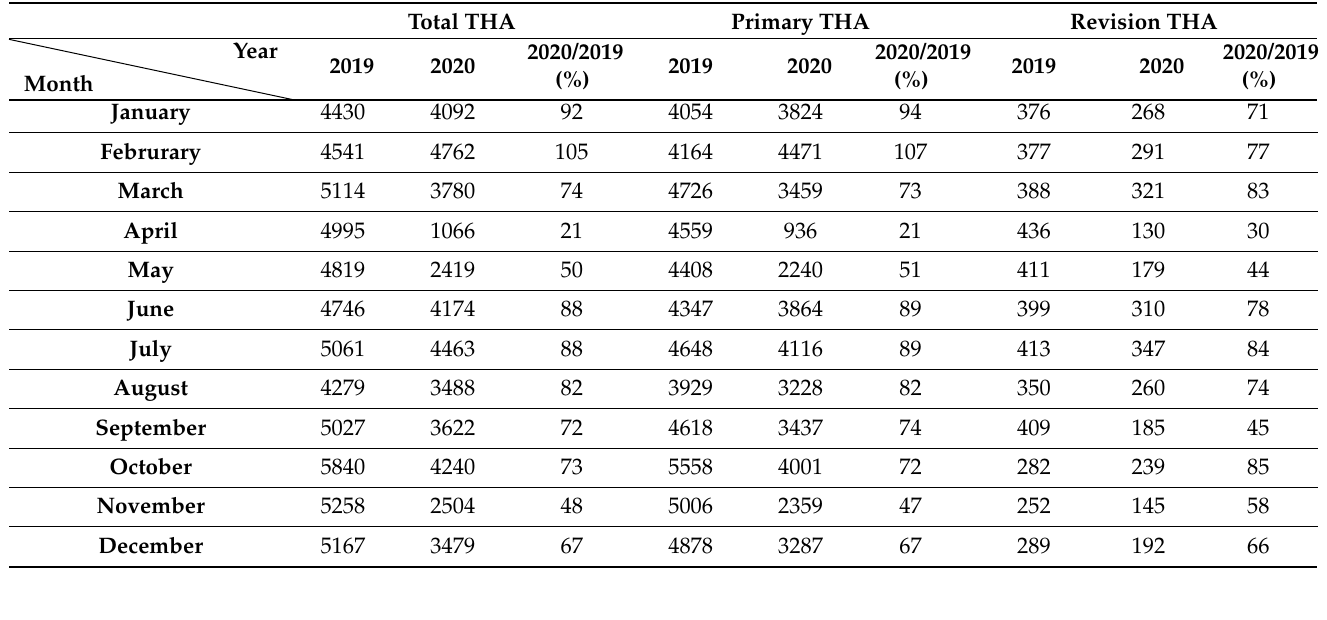
Table 3. Number of total hip arthroplasties (THA) performed in the particular months of 2019 and 2020 in Poland. Total THA Primary THA